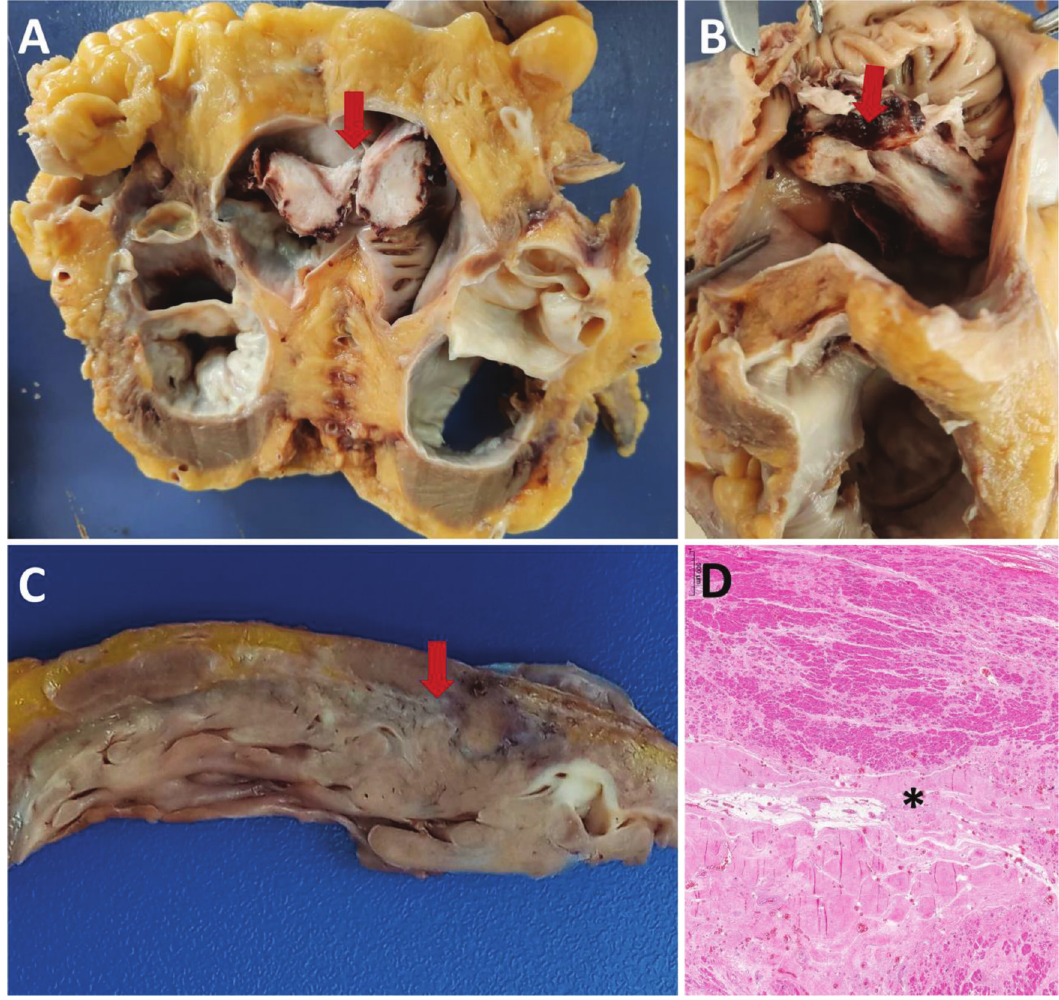
Figure 2 - A and B : Male, 56 years old, 30 days of hospitalization. A : Cross section of the heart at the atrium–ventricle transition. Bottom view of an organized thrombus in the right atrium (arrow). B : Upper view of the organized thrombus in the right atrium (arrow). C and D : Male, 76 years old, 22 days of hospitalization. Gross section (C) and histology (D) of the left ventricle showing scarring areas of ischemic heart disease (arrow in C and asterisk in D ).